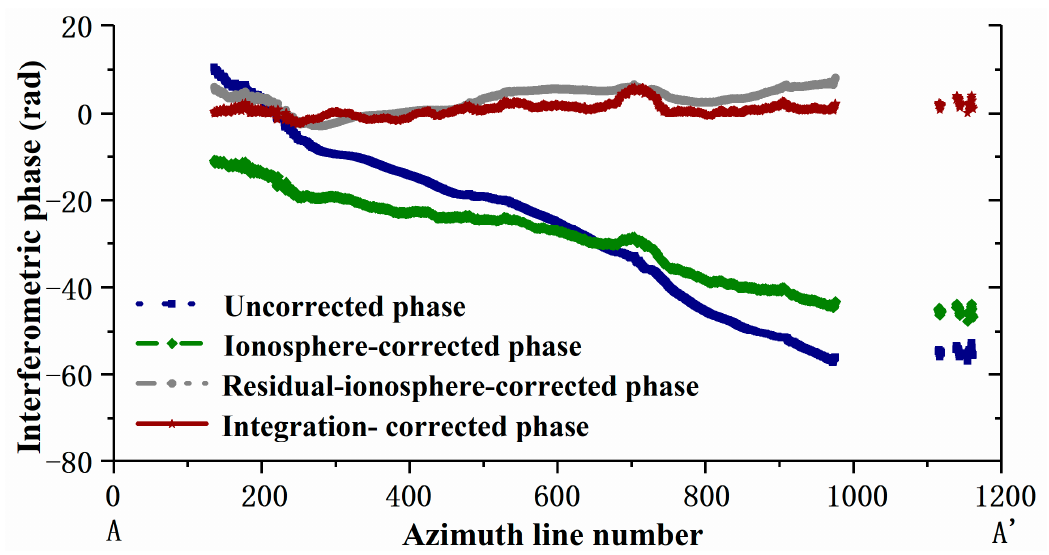
Figure 8. Comparison among the interferometric phase in the profile A-A’ in Figure 7a,c,d.